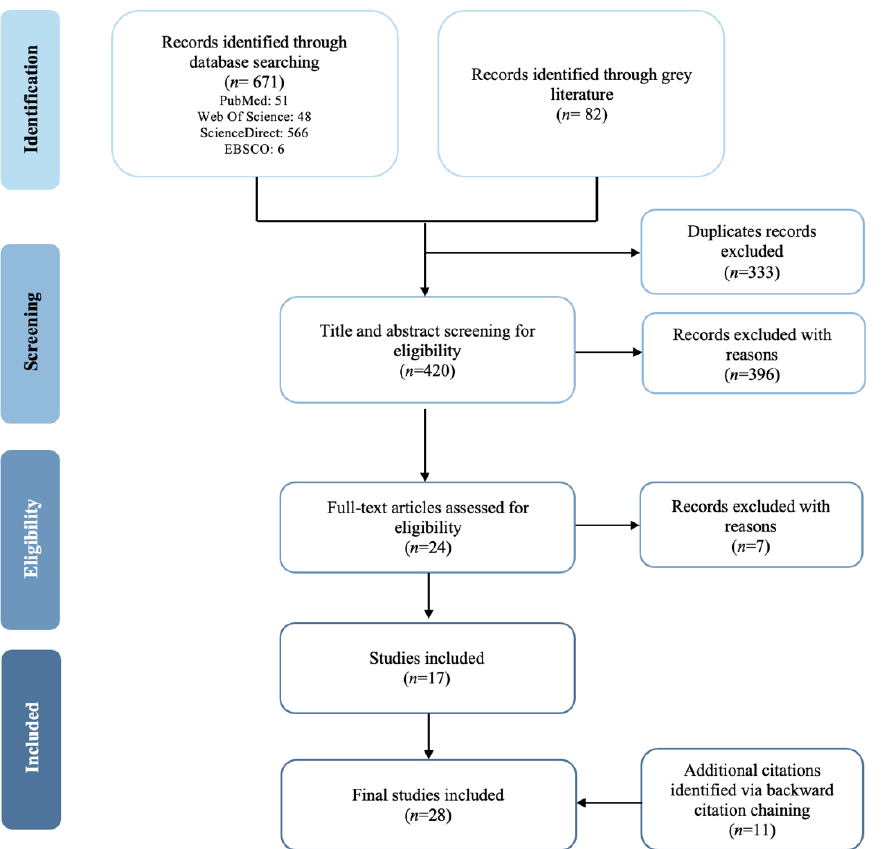
Figure 1. Preferred Reporting Items for Systematic Reviews and Meta-Analyses Extension for Scoping Reviews (PRISMA-ScR) flow diagram illustrating the search strategy.